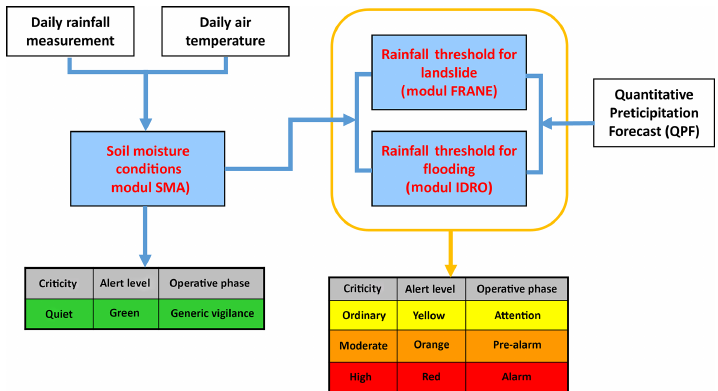
Figure 3. Layout of HEWS